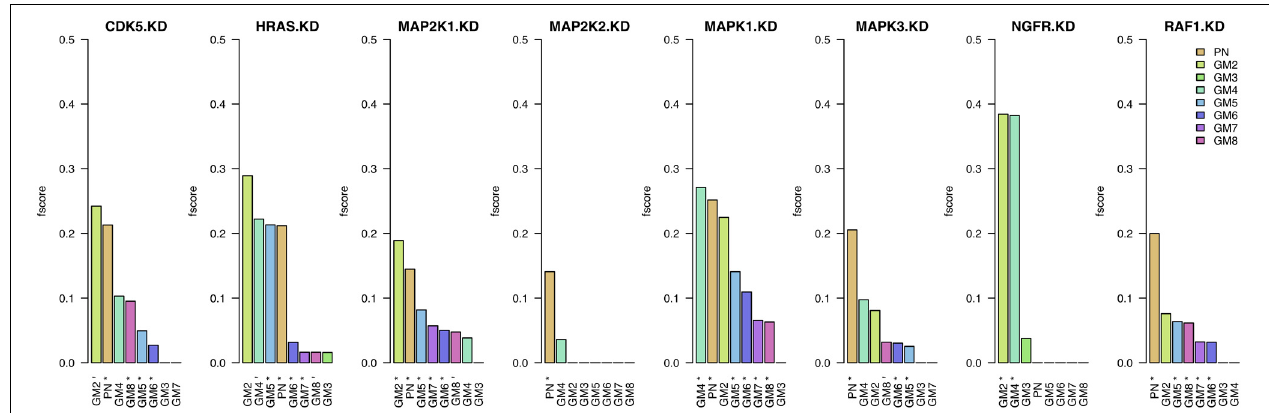
FIGURE 2 | Results when inferring networks with predictionet using only prior knowledge ( w = 1). The height of each bar corresponds to the obtained F -score, colored by prior source. The x -axis specifies the prior source and includes ∗ if the F -score is significant with p -value < 0.05 and − for p -values <